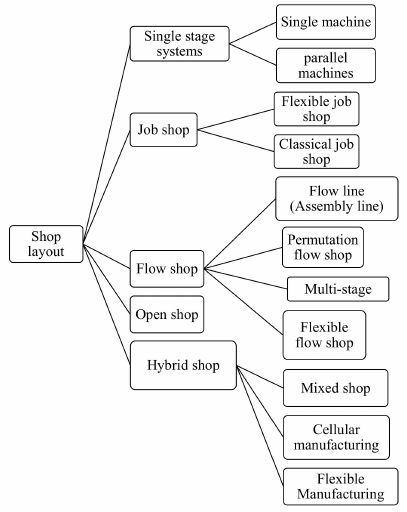
Figure 5. Shop layout